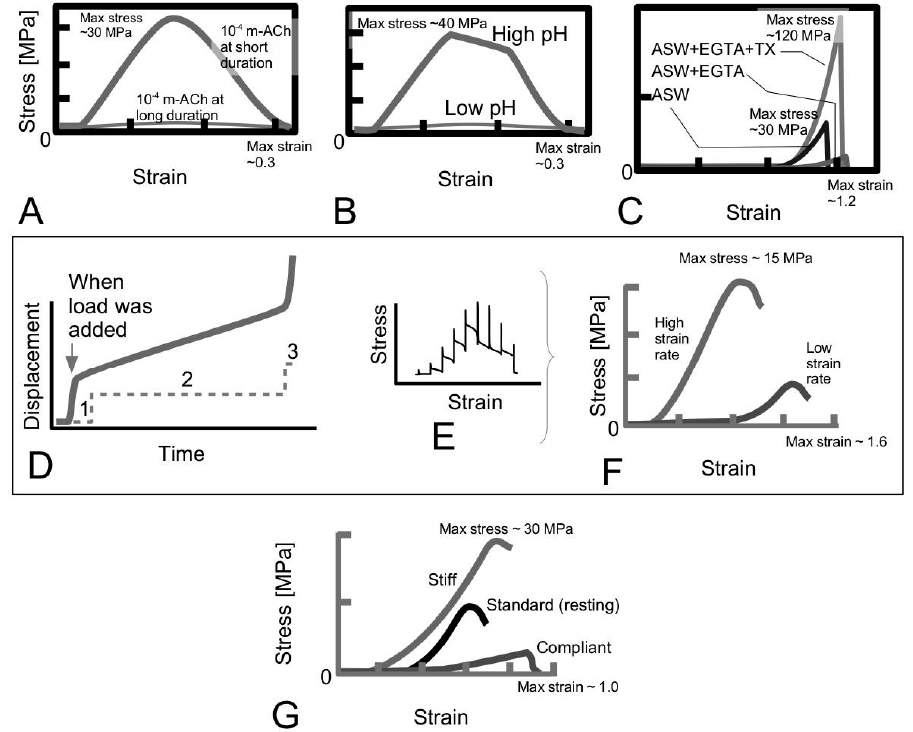
Figure 3. Profiles of the stress versus strain curves of mutable collagenous tissues (MCTs). ( A ) A sketch of the graph of stress versus strain of the CA, sea urchin ( Anthocidaris crassispina ) [15]; ( B ) A sketch of the graph of stress versus strain of the catch apparatus, sea urchin ( Anthocidaris crassispina ) [16]; ( C ) A sketch of the graph of stress versus strain of the tube feet tissue, sea urchin ( Paracentrotus lividus ) [70]; Sketches of ( D ) the graph of displacement versus time, indicating the primary (#1), secondary (#2) and tertiary (#3) phases; thereafter rupture results; ( E ) the graph of incremental stress versus strain and ( F ) the graph of stress versus strain (derived from E ) of the compass depressor ligament, sea urchin ( Paracentrotus lividus ) [66]; ( G ) Sketch of graph of stress versus strain of the dermis of the sea cucumber ( Cucumbria frondosa ) [23] for the purpose of comparison with the results from the sea urchin ( A – F ). Symbols in the graphs: ACh represents acetylcholine; ASW, artificial sea water; EGTA, ethylene- bis -(oxyethylenenitrilo)-tetraacetic acid (calcium chelator); TX, Triton X100. Figure 3G shows a sketch of the graph of the stress versus strain of the dermis from the sea cucumber derived at the respective state, namely stiff, standard (i.e., intermediate/resting) and compliant states [23]. These sketches are shown here for the purpose of comparison with the stress- strain curves from the three different tissues of the sea urchin. As expected, the stress versus strain curve shows a very steep gradient for the tissue in a stiff state as compared to the tissue in a compliant state; the peak stress is also higher in the former than in the latter tissue. Of note, Trotter and co-